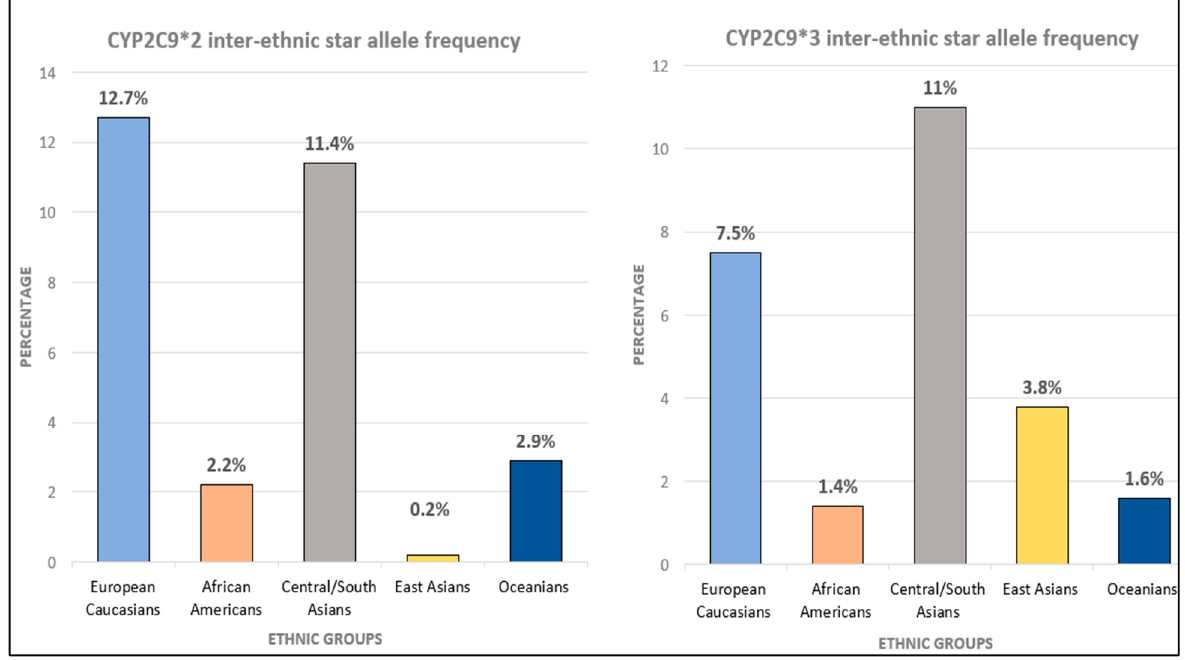
Figure 4. CYP2C9 inter-ethnic star allele frequency (https://www.pharmgkb.org/page/cyp2c9RefMaterials, PharmGKB), accessed on 8 February 2022 [80].